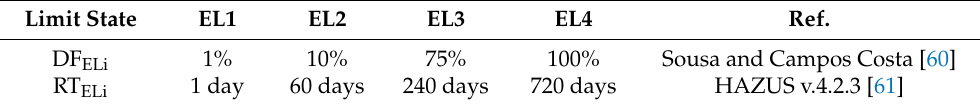
Table 5. Definition of damage factor and recovery times associated with response limit states.